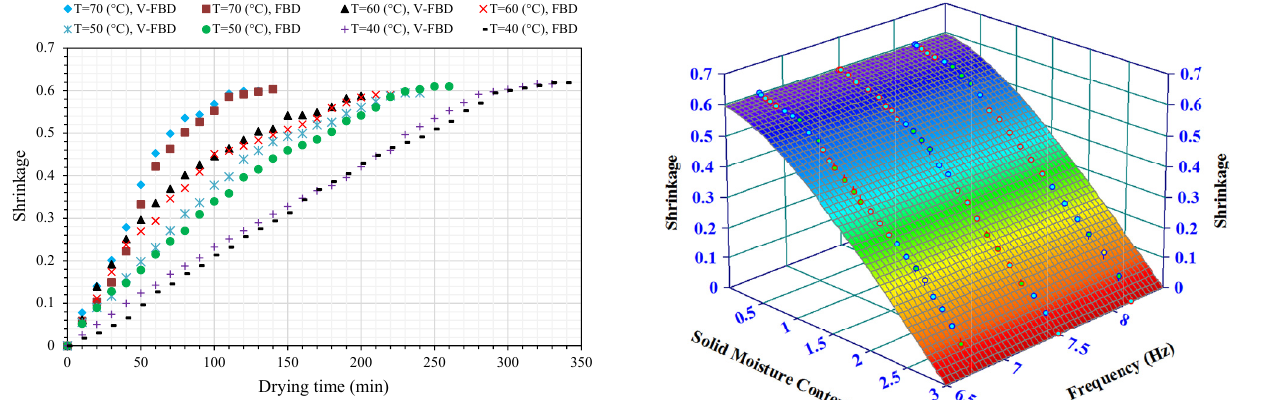
Fig. 8. Variation of hawthorn shrinkage versus solid moisture content at different vibration intensity (drying air flow rate=26 m 3 /h and drying air temperature=50 o C)